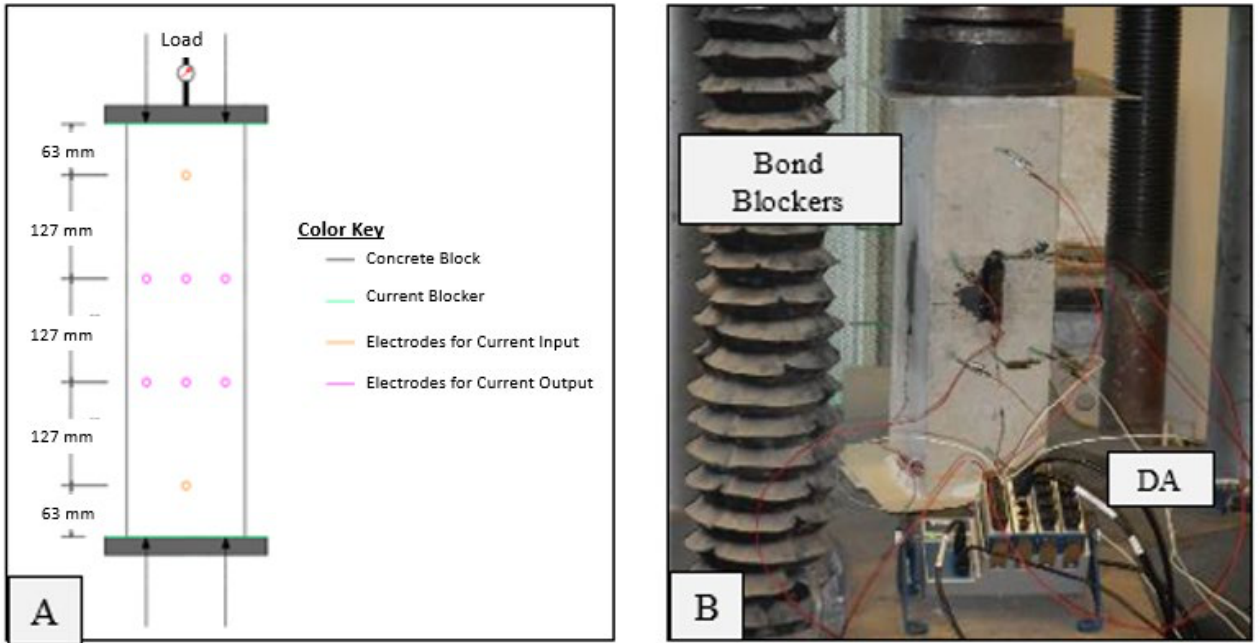
Figure 2. Proposed ( A ) and actual ( B ) test specimen (150 × 150 × 500 mm) for electro-elastic testing.